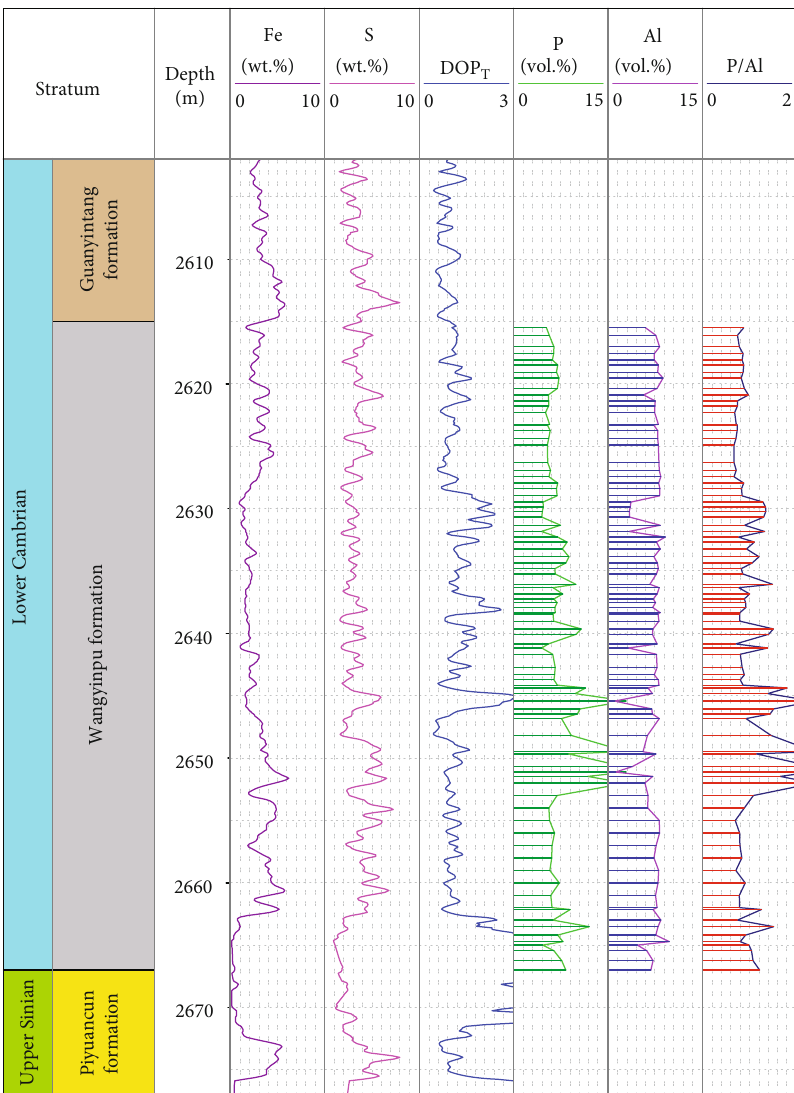
Figure 2: Redox environment index (DOP ) and biological productivity (P/Al) of the Lower Cambrian Wangyinpu Formation in Well JXY1. T See Figure 1 for the well